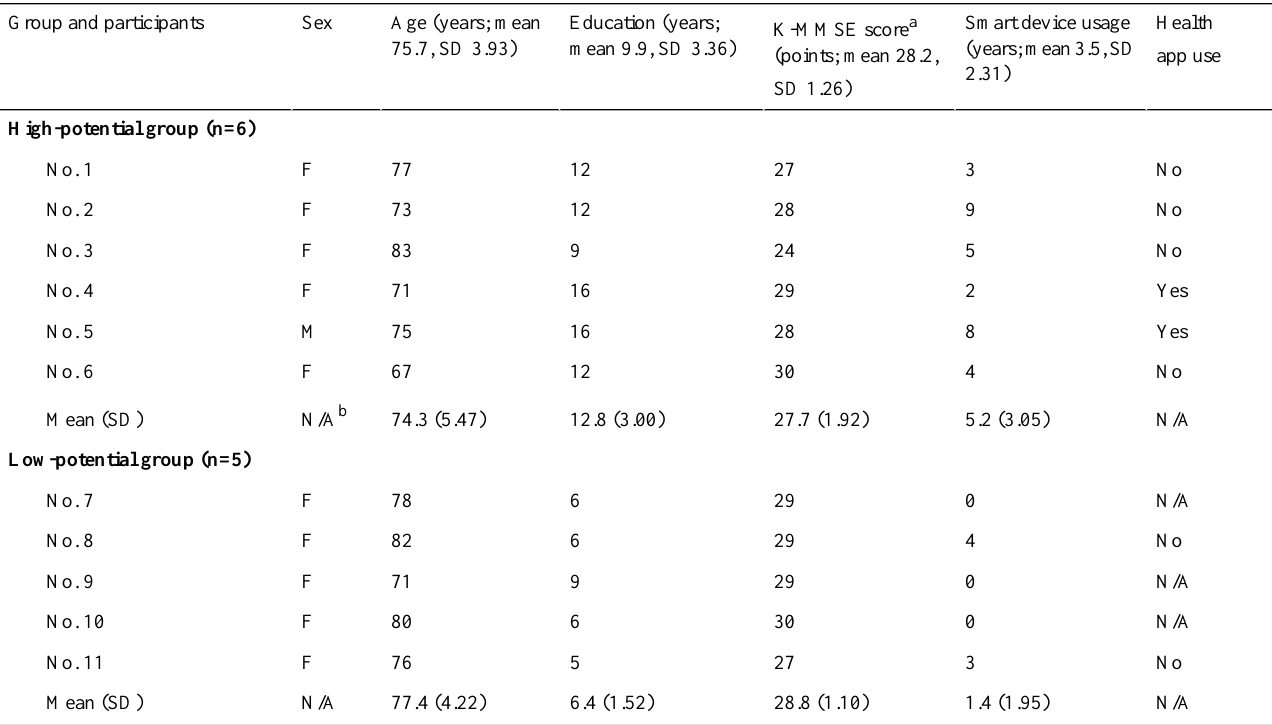
Table 1. Demographic characteristics of the participants (N=11).